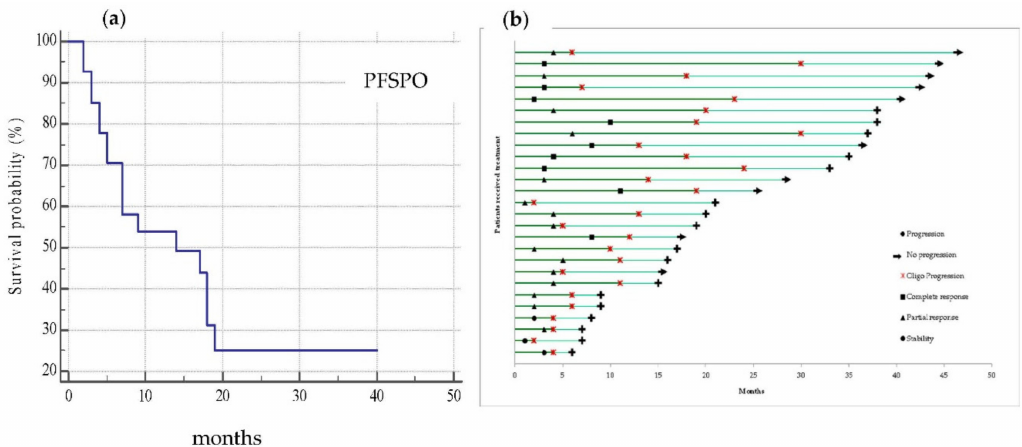
Figure 3. ( a ) Kaplan–Meier curve representative of progression-free survival post oligoprogression (PFSPO) which median value was 14 months (5–19 95% C.I.) with 10 patients not progressed at time of analysis; ( b ) the swimmer plot shows the treatment and follow-up history for all 27 patients who developed an oligoprogression and were treated with local approaches and treatment beyond progression (TBP). Each bar represents one patient.